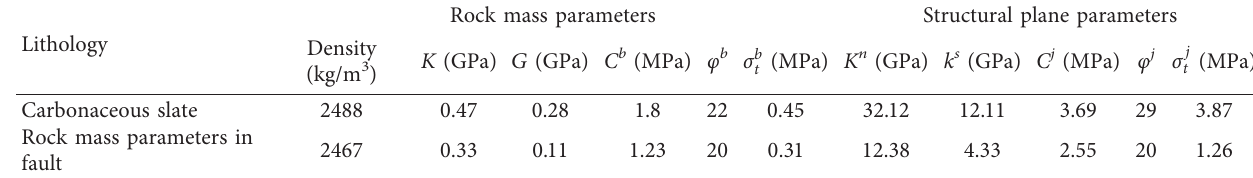
Table 1: Calculation